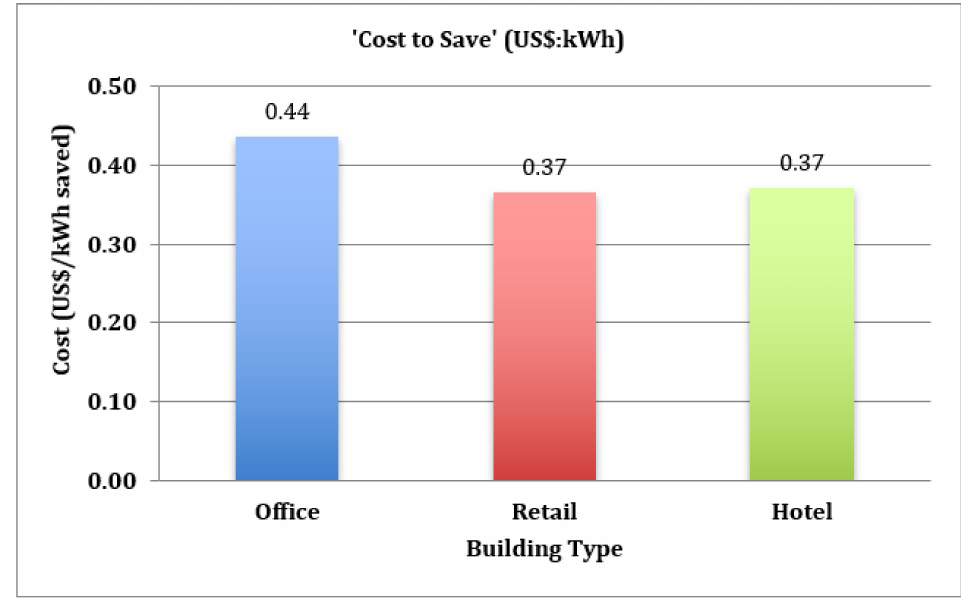
Figure 6. The investment required to deliver savings